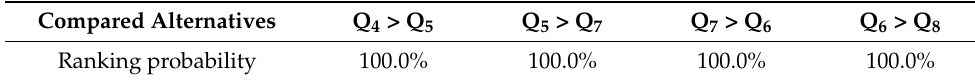
Table 8. Ranking probabilities of compared